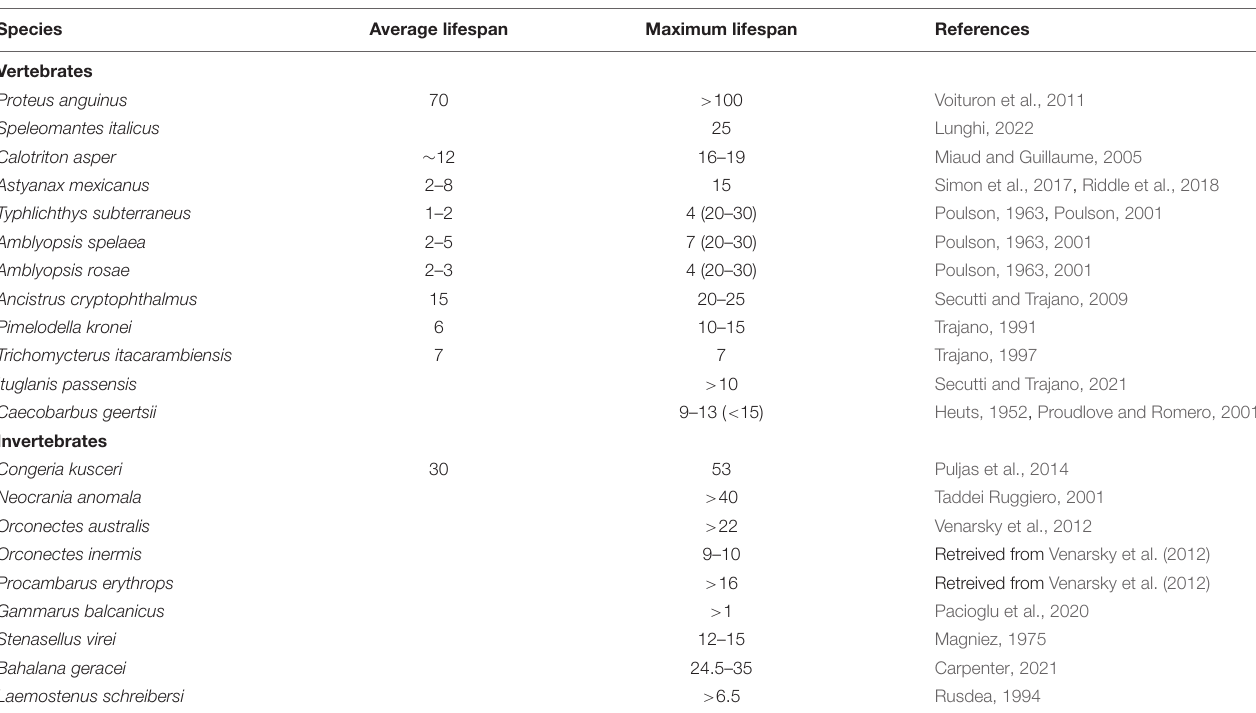
TABLE 1 | Summary of the lifespan data for cave species collected in this review.